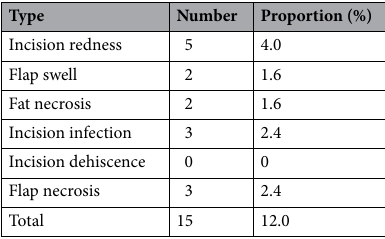
Table 1. The type of poor wound healing.